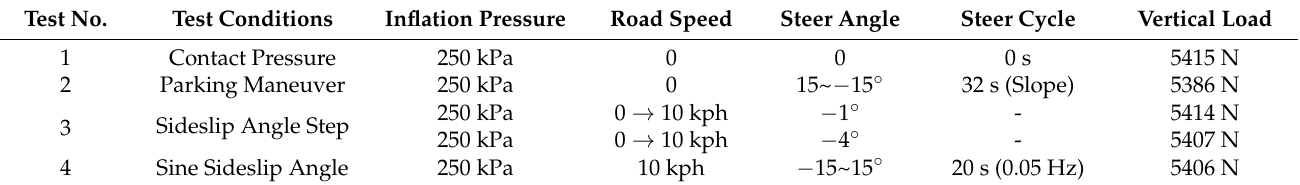
Table 3. The test